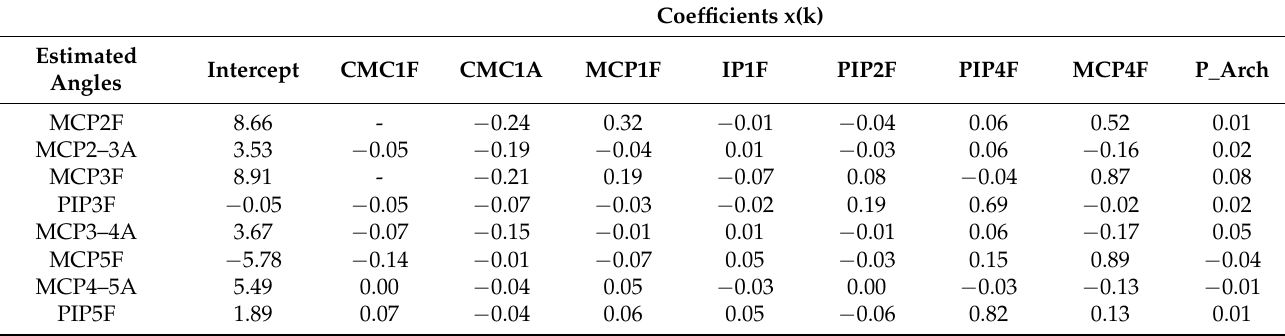
Table 4. Coefficients x(k) obtained for each of the representative joint angles, in order to estimate Table 1. All the coefficients presented are significant with a p -value of 0.05. 1 to 5 refers to thumb to little fingers. F stands for flexion/extension and A for abduction/adduction movements.